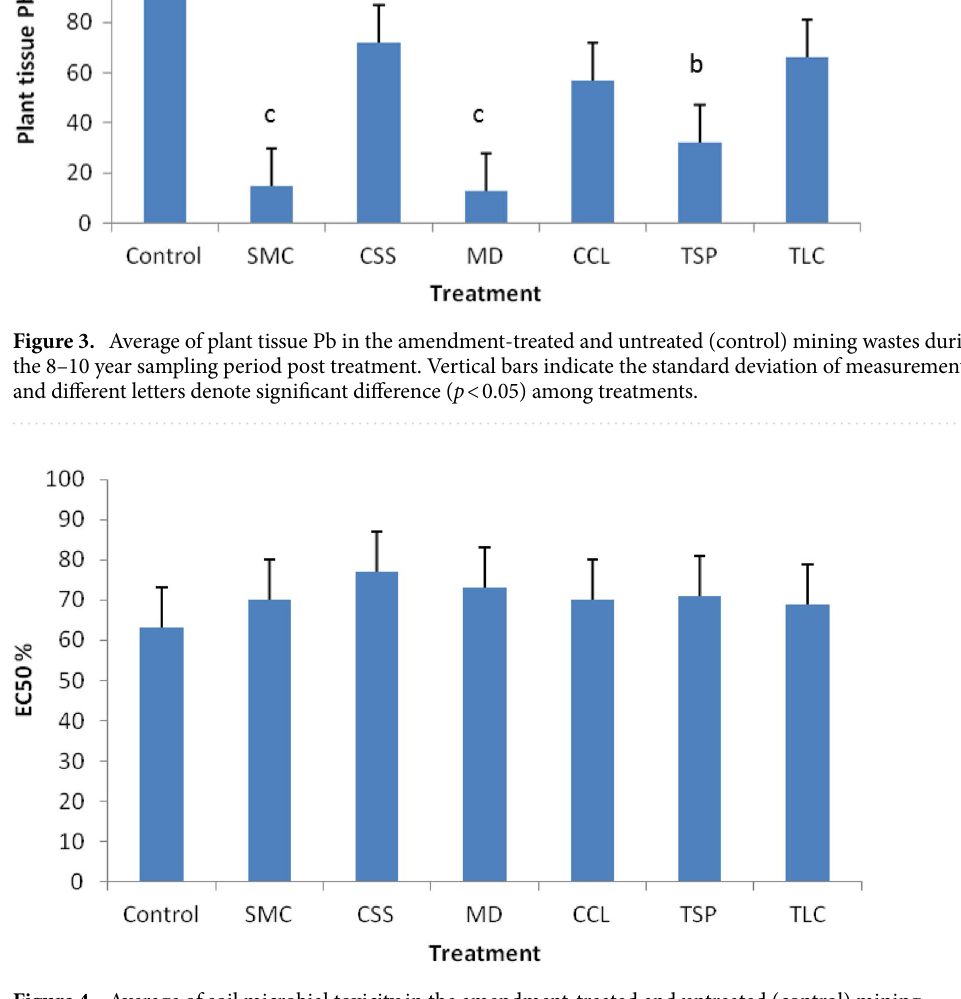
Figure 4. Average of soil microbial toxicity in the amendment-treated and untreated (control) mining wastes during the 8–10 year sampling period post treatment. Vertical bars indicate the standard deviation of